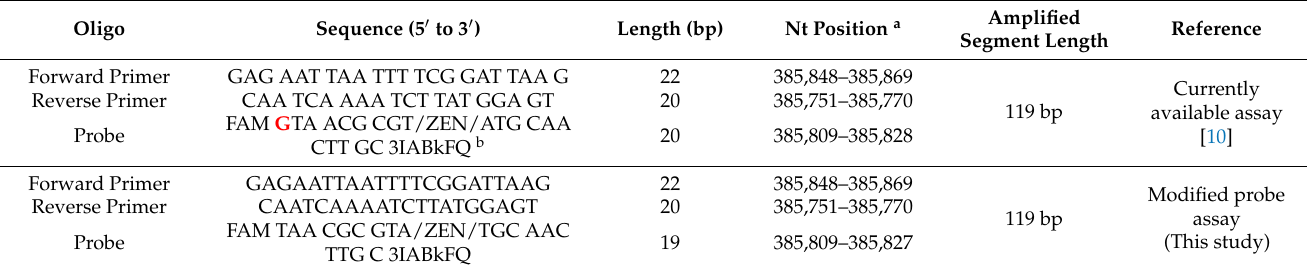
Table 1. Oligonucleotides characteristics of the three ORT TaqMan qPCR assays included in this